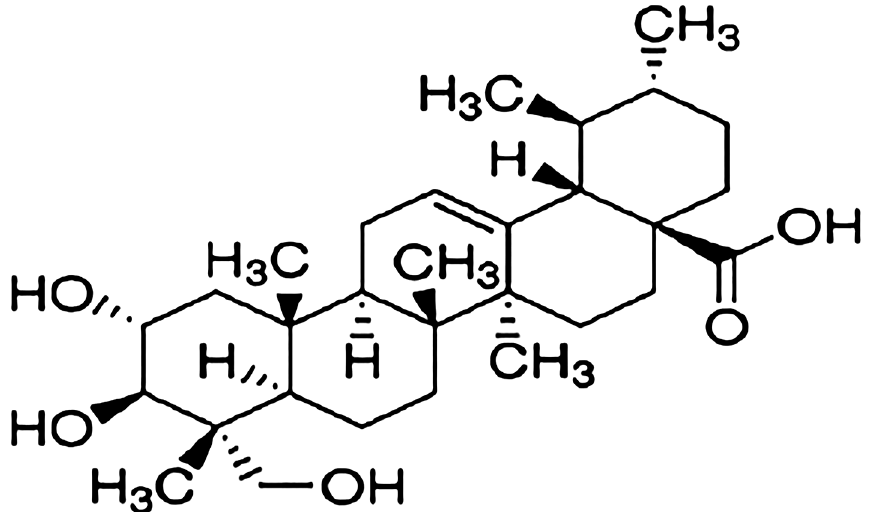
Figure 1. Structure of